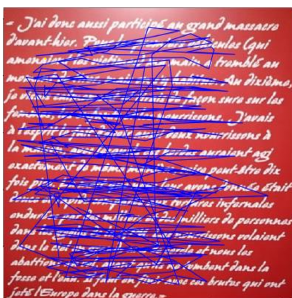
Figure 4. A participant's gaze trajectory from the fixation points on a letter sent by a Waffen SS to his wife.